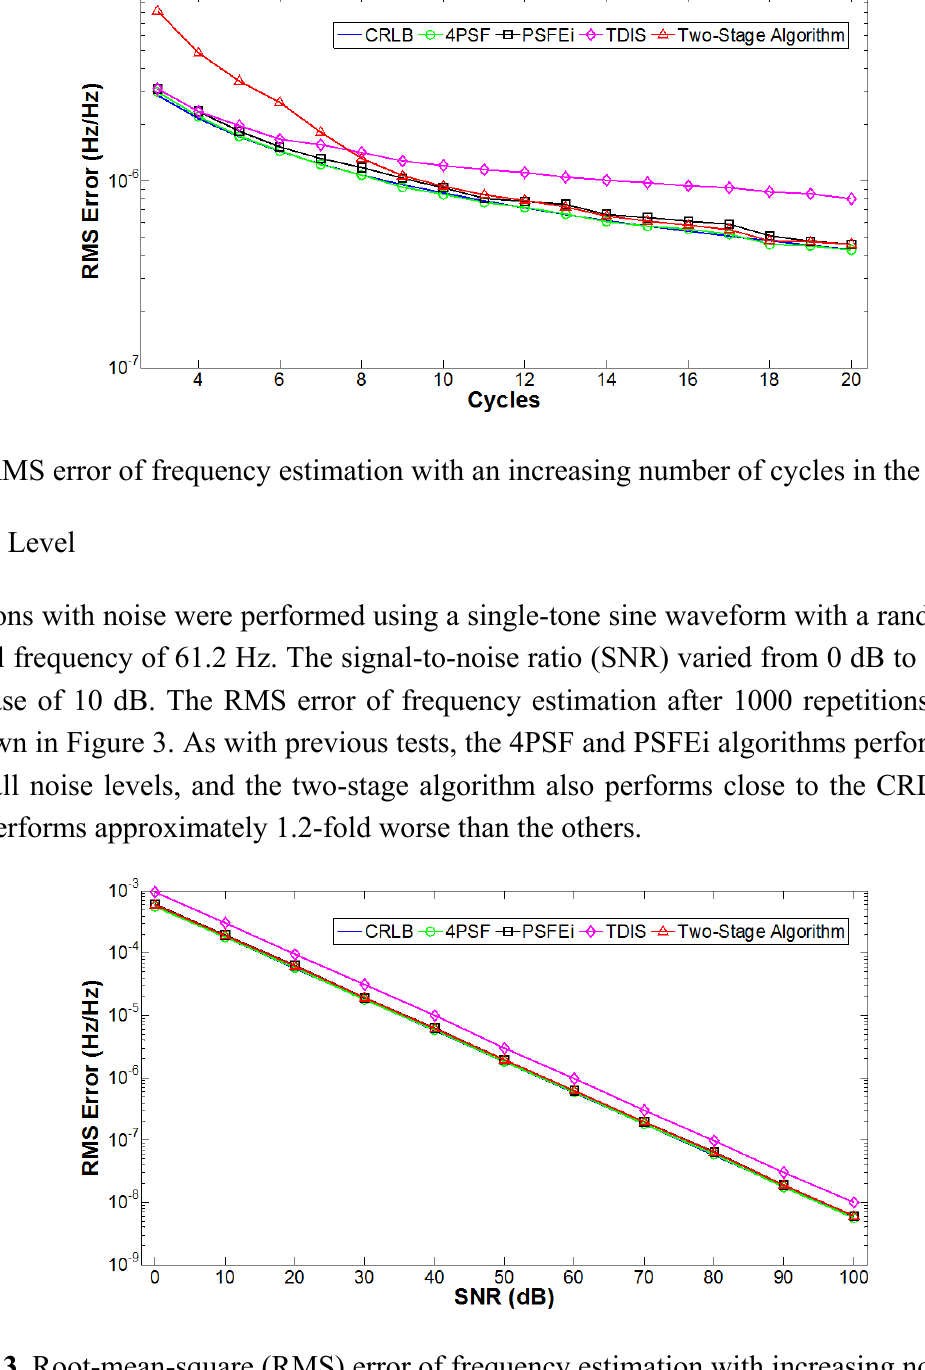
Figure 3. Root-mean-square (RMS) error of frequency estimation with increasing noise